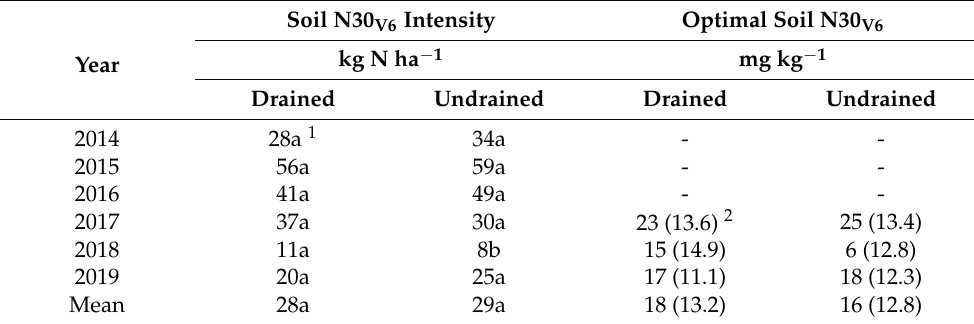
Table 5. In-season soil NO 3 − -N intensity measured at 0 to 30 cm soil depth at the V6 corn develop- ment stage (soil N30 V6 ) averaged across the PL-0 and PL-135 kg N ha − 1 treatments (only treatments that were measured for N30V6 every growing season), and soil N concentrations at the ONR (optimal soil N30 V6